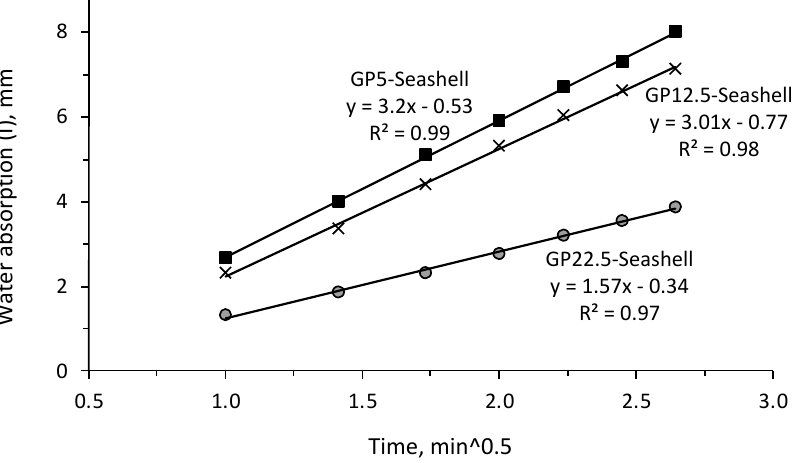
Figure 7. Typical plots for variations in water absorption as a function of time.